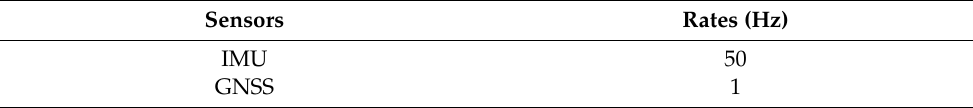
Table 1. Sensor rates setting.